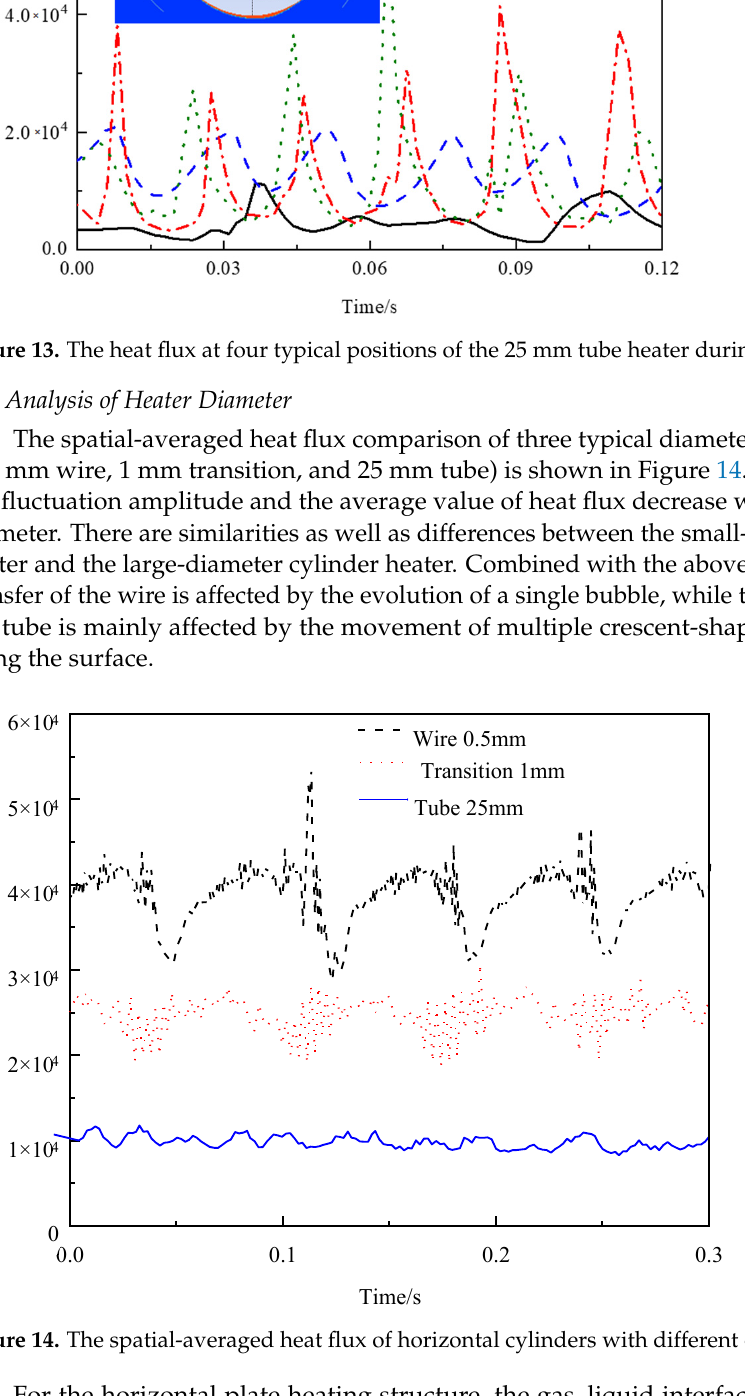
Figure 12. The spatial-averaged heat flux and the evolution of the gas–liquid interface for the 25 mm tube.